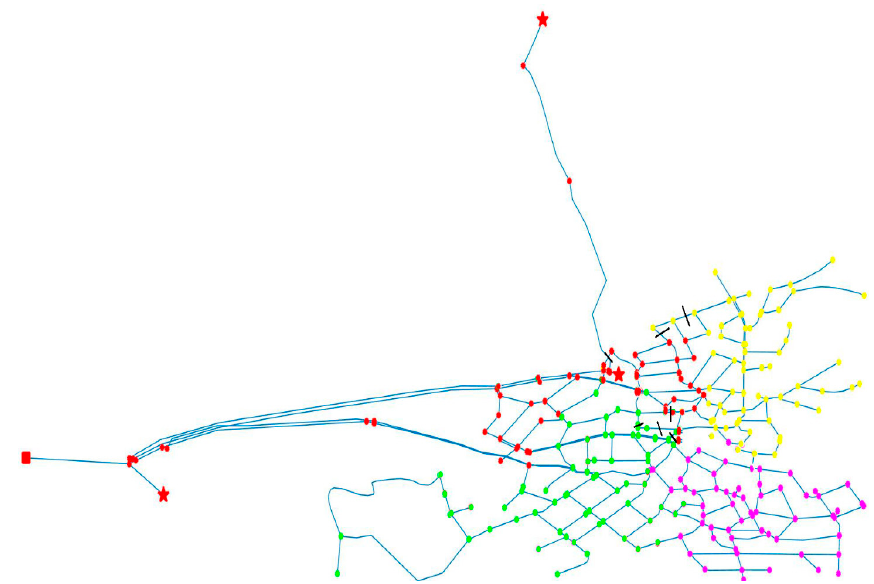
Figure 3. Separation of the Aiani’s network into DMAs with the proposed pipes for closing by the model being marked with black color.